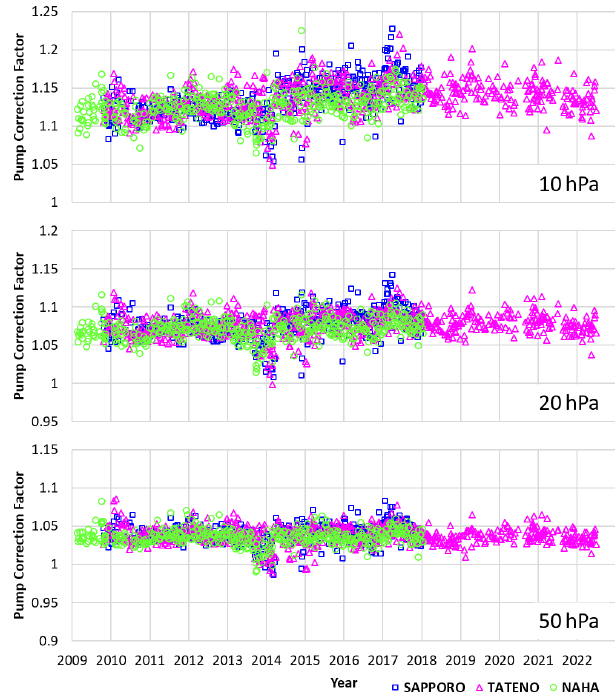
Figure 14. Pump correction factors for 2009 to 2022 (top to bottom: 10, 20, and 50hPa). Over this 11-year period, the factor has changed by + 1% at 50hPa, + 2% at 20hPa, and + 4% at 10hPa.